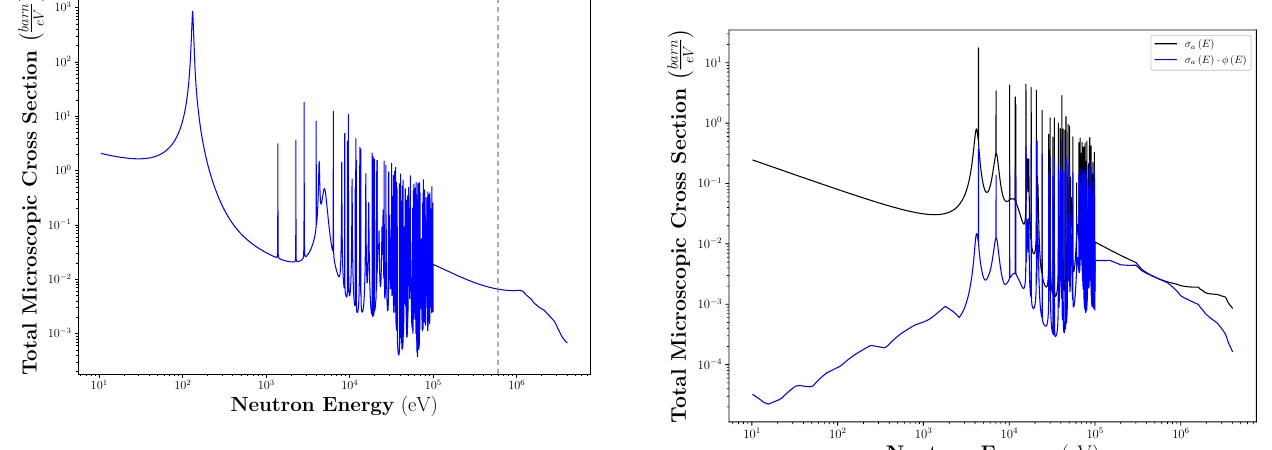
Fig. 2. The total microscopic ( n,γ ) cross section for 59 Co from the ENDF/B- VII.1 library, courtesy of the NNDC [3], [4]. The gray dotted line represents the peak neutron energy in an SFR spectrum at 0.5 MeV. Peaks in the neutron cross section, also termed resonances, correspond to nuclear levels. 59 Co displays the typical structure wherein at low energies the distance between levels is large (resonance at ~100 eV) followed by an increase in level density (1 - 100 keV) resulting in an eventual continuum (¿ 100 keV) where individual levels can no longer be resolved.